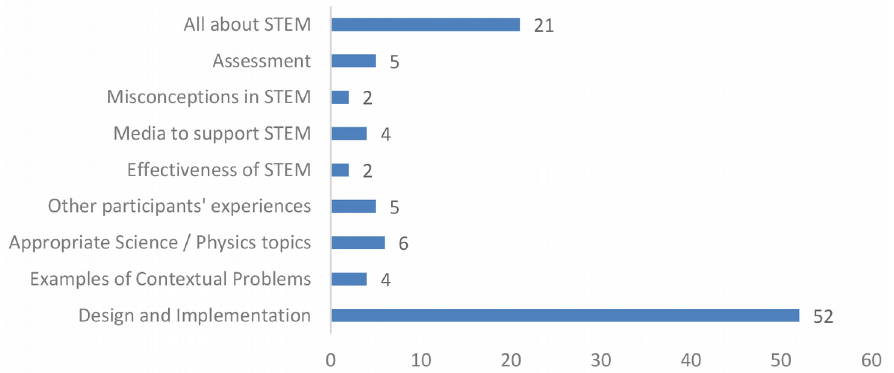
Figure 8. Further needs for STEM professional